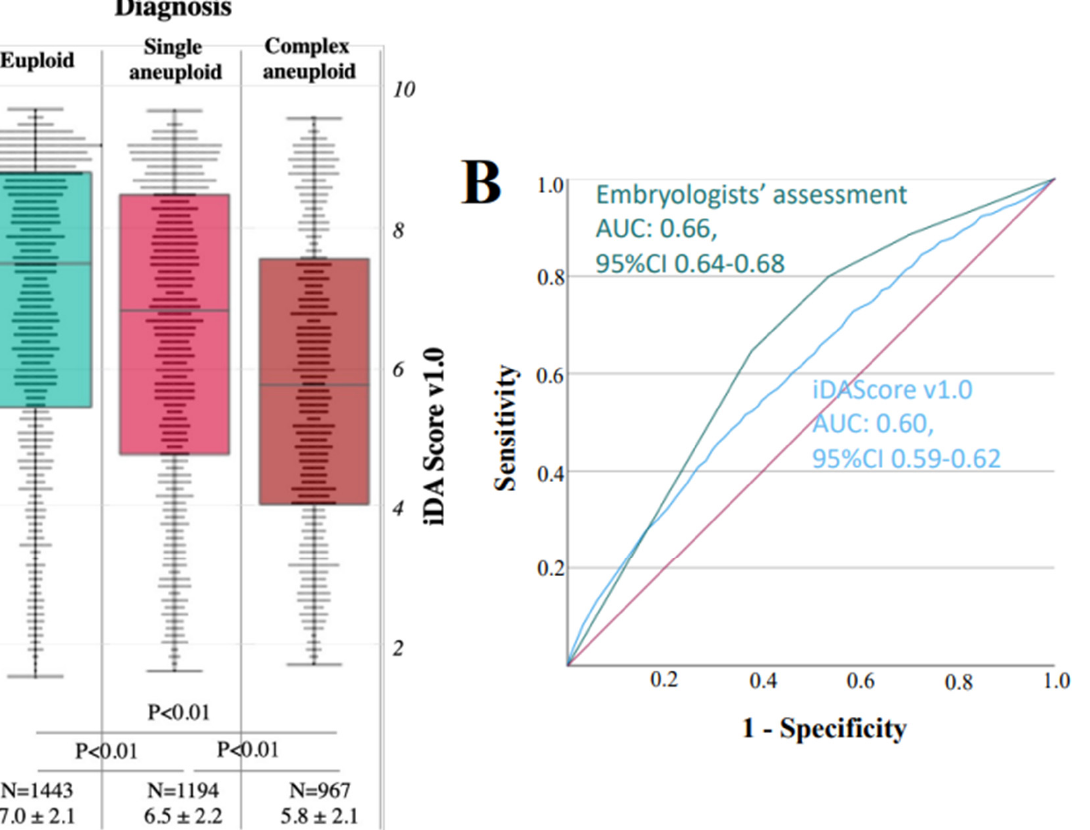
- Table 2. Logistic regressions for the association between embryologists’ assessment with euploidy (adjusted for maternal age) and live birth (LB) after euploid single embryo transfer (SET). Outcome: euploidy Univariate OR, 95% CI, p -value